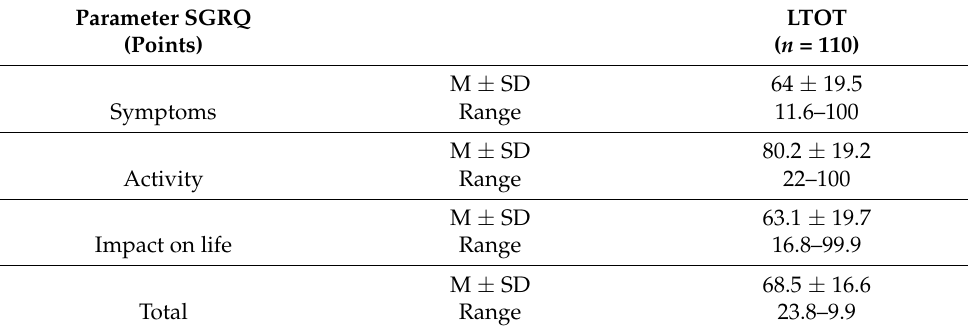
Table 4. Characteristics of the quality of life in patients in the study